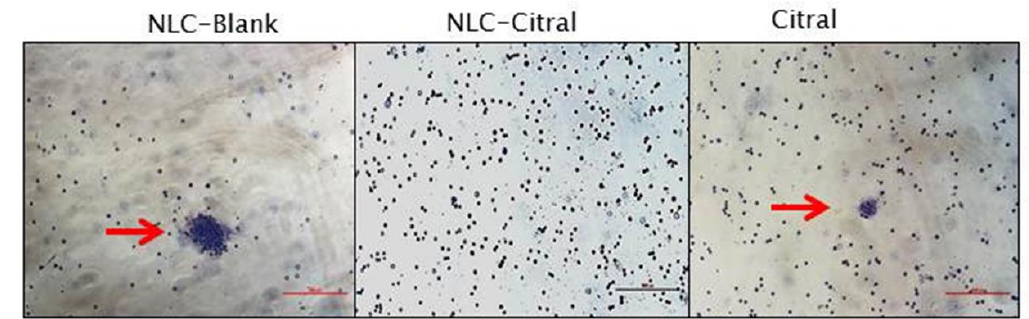
Figure 7. The representative images and bar chart analysis of the lung clonogenic assay at a dilution factor of 10 4 . Lung was harvested from all groups of mice. Each value in the bar chart is represented as mean ± SD, the experiment was performed in triplicate. Significance indicated by different alphabet was set at p < 0.05 comparing between groups.